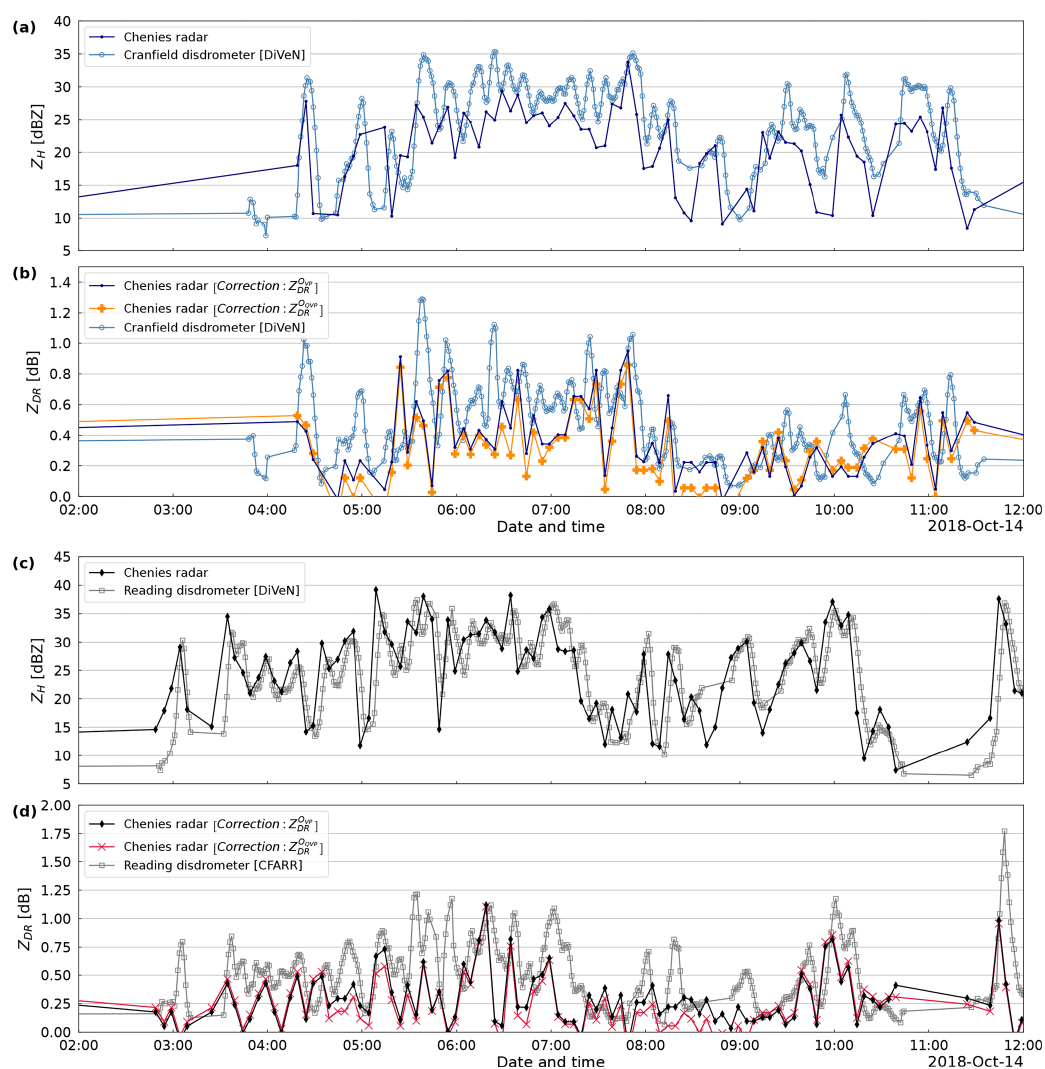
Figure 11. Time series of disdrometer and radar measurements. Panels (a) and (c) show the reflectivity, whereas panels (b) and (d) show the differential